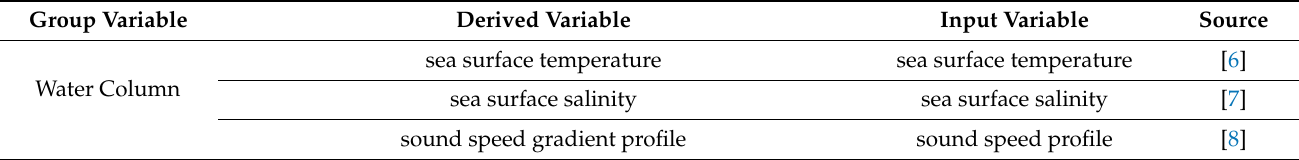
Table 1. List of input and derived variables that affect sound